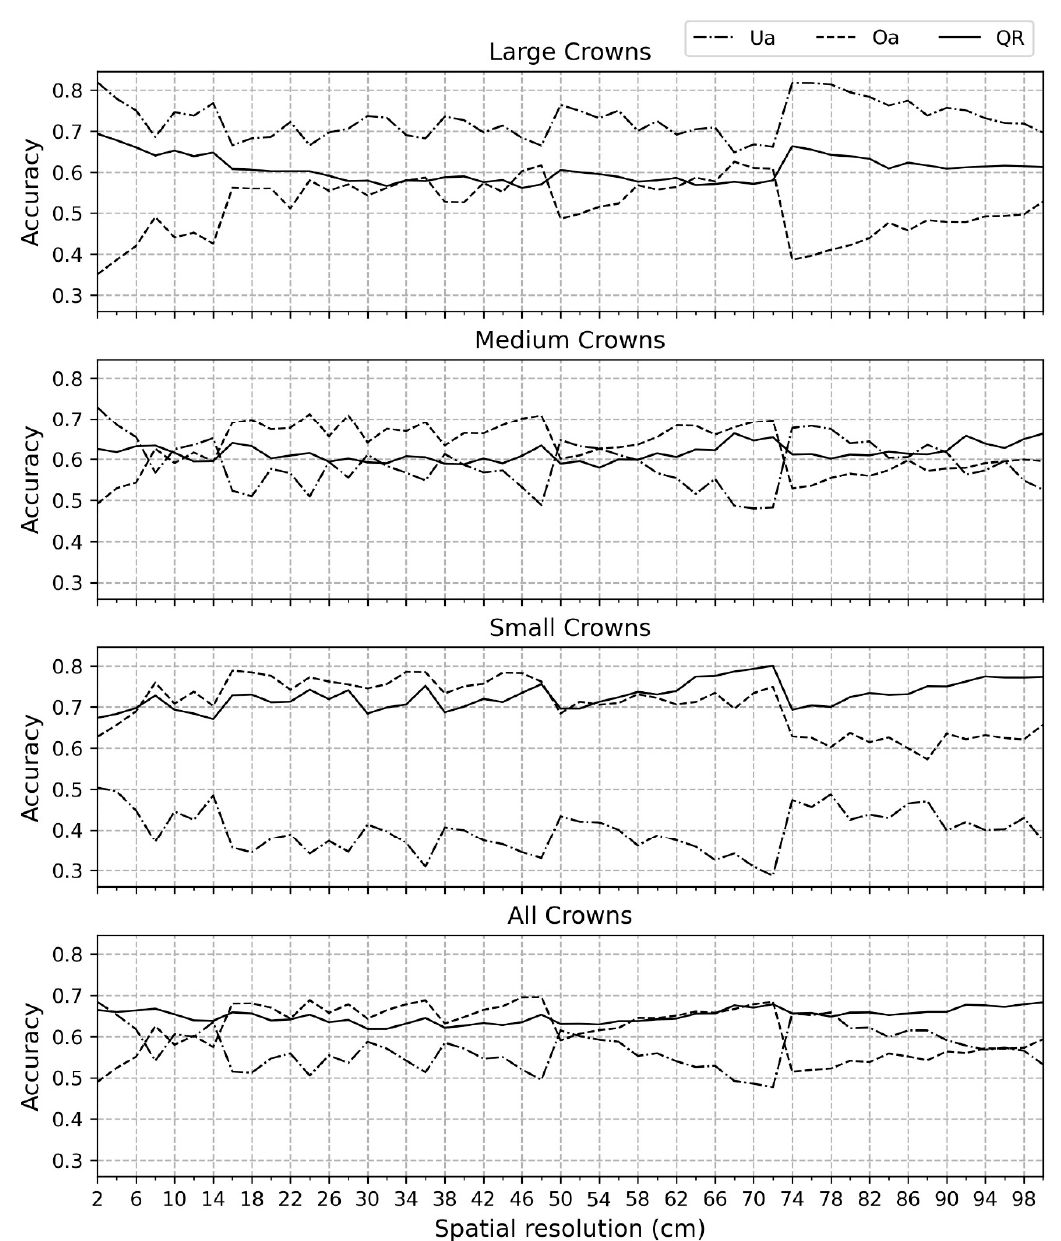
Figure 2. Impact of spatial resolution and crown size on Oa, Ua, and QR using the lightness band in study site #1.